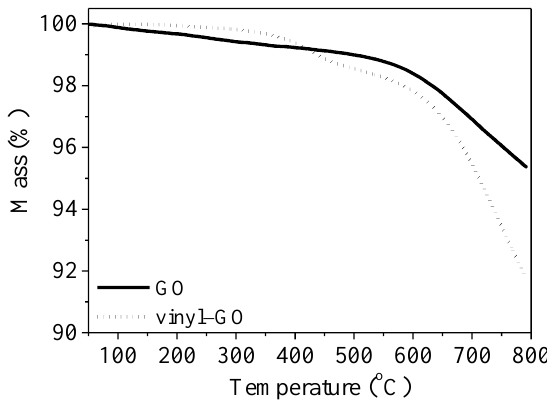
Figure 3. TG curves of GO and vinyl − GO.